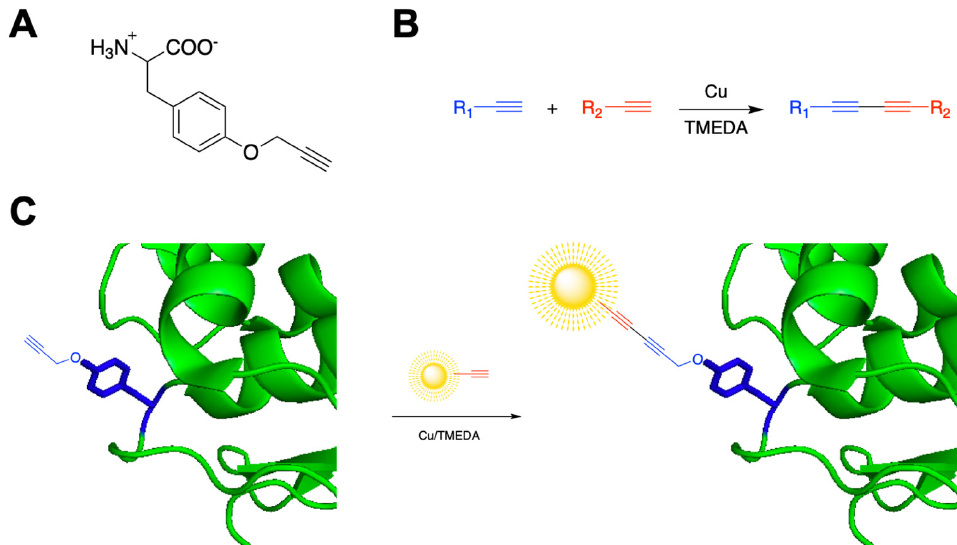
Figure 1. Bioconjugation strategy for preparation of modified UTAG diagnostic proteins. ( A ) The p -propargyloxyphenylalanine ( p PrF) ncAA structure. ( B ) Representative Glaser–Hay conjugation of two terminal alkynes to generate a conjugated diyne. ( C ) Genetic incorporation of p PrF into UTAG followed by a Glaser–Hay bioconjugation with a fluorescent terminal alkyne to selectively label the protein.